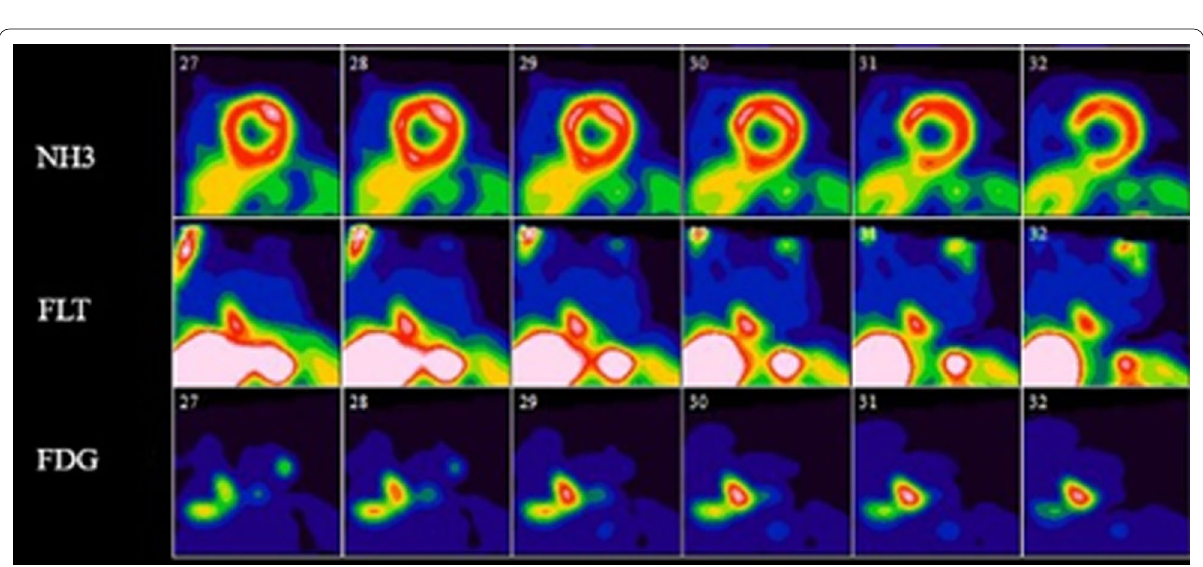
Fig. 4 Selected short axis images of cardiac perfusion PET (top), FLT (middle), and FDG (bottom) studies in short, vertical, and horizontal long axes in a single subject with CS. The findings were consistent with active CS on both the FLT and FDG studies. The images show the relationship between an area of scarring in the inferior aspect of the ventricular septum which overlaps an area of concordant uptake on both FDG and